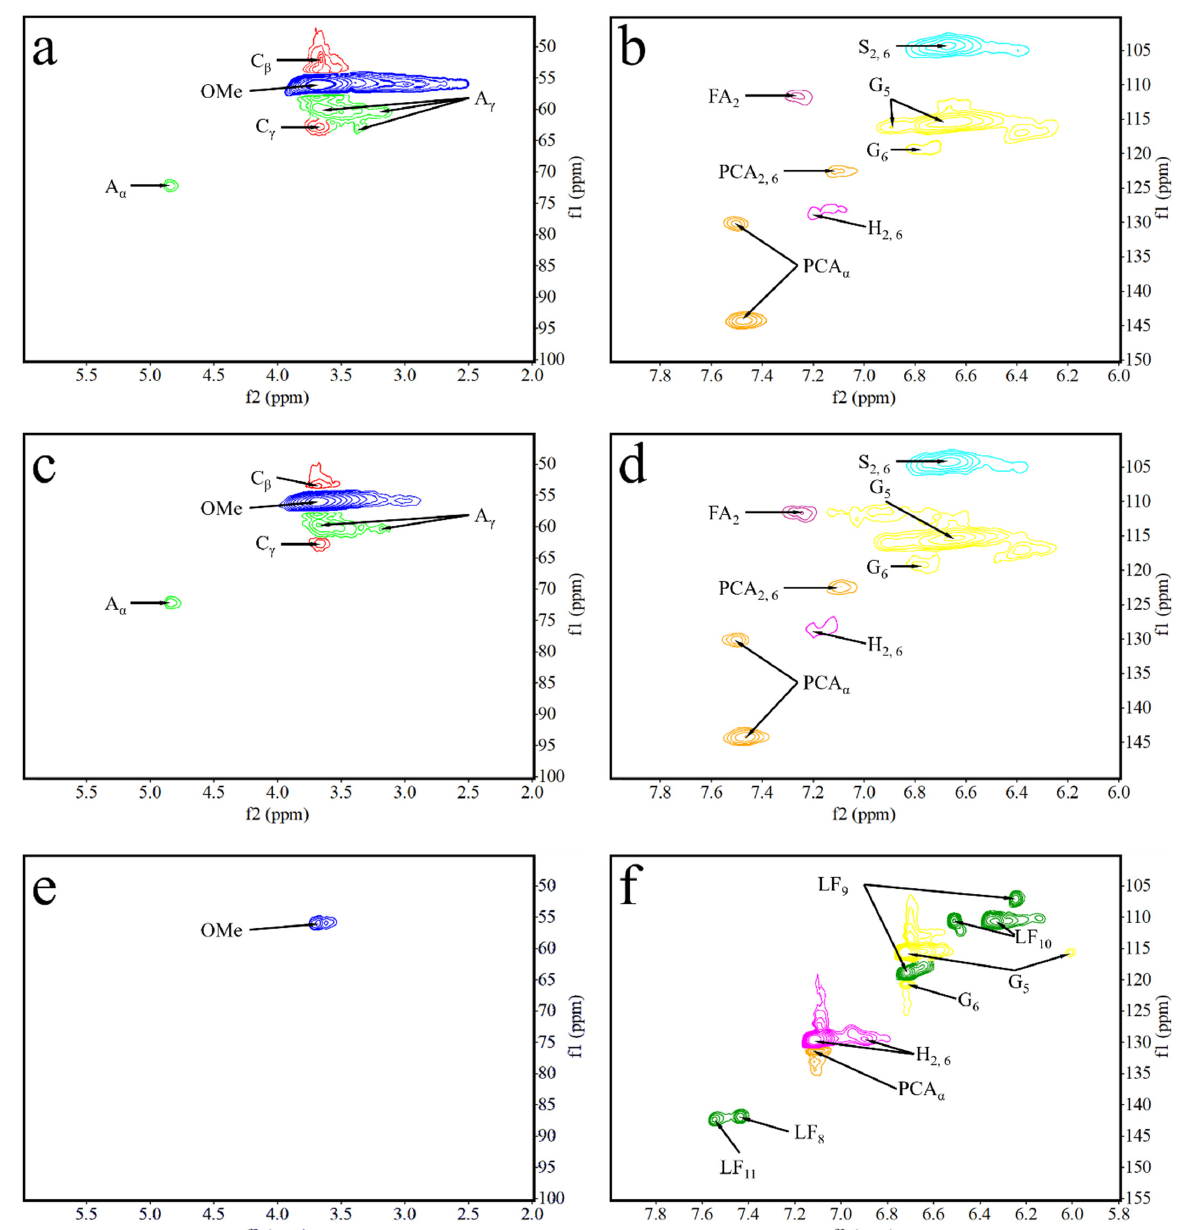
Figure 10. 2D-HSQC spectra of EHL, HEHL, model compounds samples: ( a ) Side-chain ( δ C / δ H 45 − 100/2.00 − 6.00) regions of EHL, ( b ) aromatic ( δ C / δ H 100 − 150/6.00 − 8.00) regions of EHL, ( c ) Side-chain ( δ C / δ H 45 − 100/2.00 − 6.00) regions of HEHL, ( d ) aromatic ( δ C / δ H 100 − 150/6.00 − 8.00) regions of HEHL, ( e ) Side-chain ( δ C / δ H 45 − 100/2.00 − 6.00) regions of model compounds, and ( f ) aromatic ( δ C / δ H 100 − 150/6.00 − 8.00) regions of model compounds.